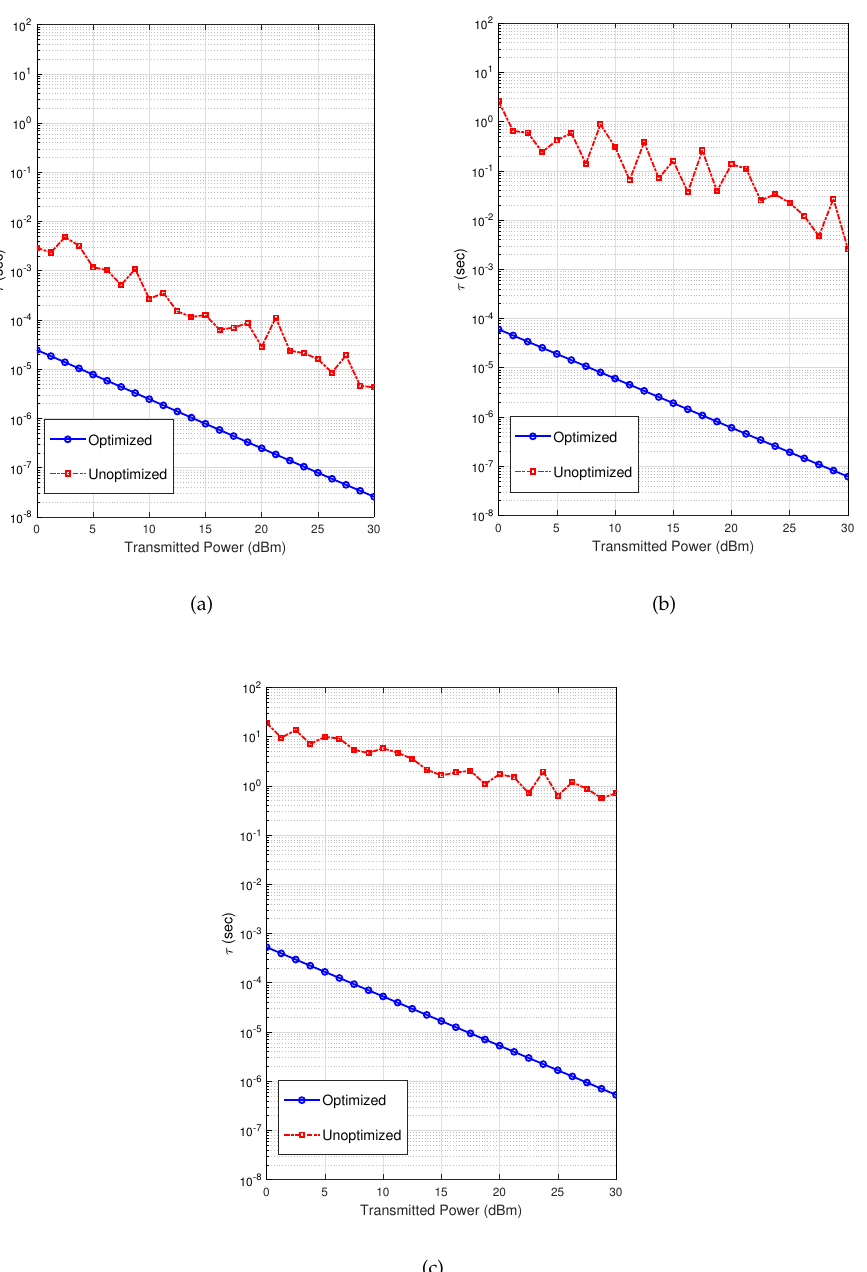
Figure 4. The transmission delay vs. transmission power at n = 500, α y ( 0 ) = 2, α y ( 1 ) = 3, r f = 100 m , and r c = 500 m ; ( a ) α x ( 0 ) = 2, α x ( 1 ) = 3; ( b ) α x ( 0 ) = 2, α x ( 1 ) = 4; ( c ) α x ( 0 ) = 3, α x ( 1 ) =